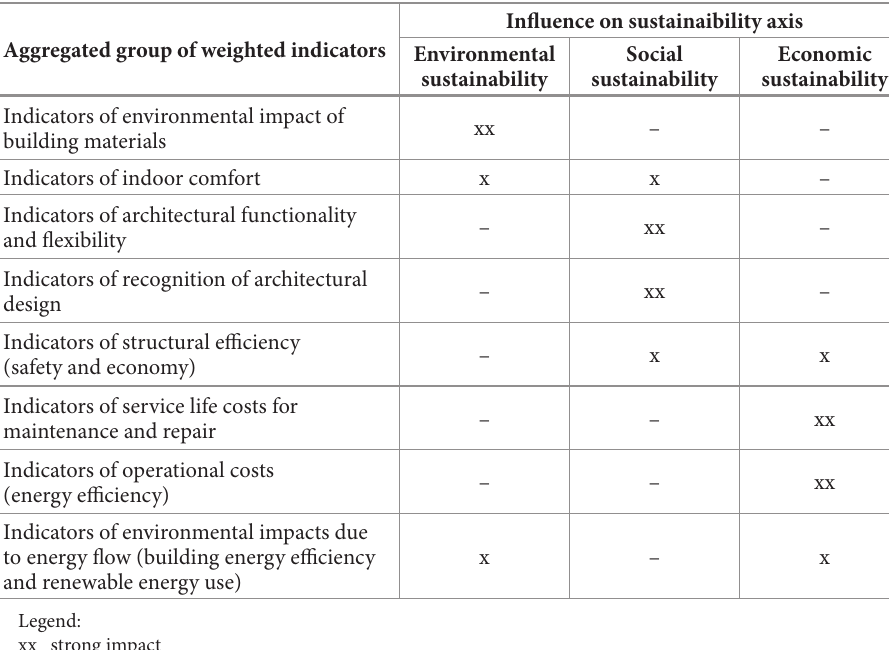
Table 6. Eight groups of aggregated and weighted indicators and their influence on sustainability areas